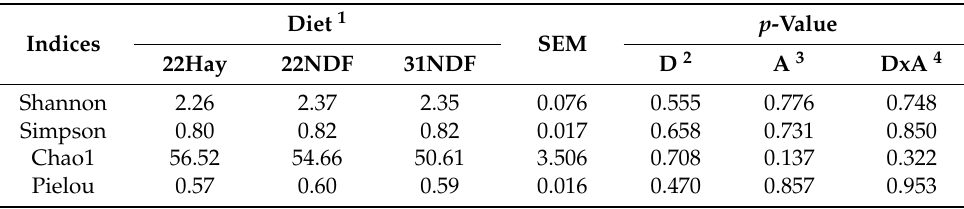
Table 2. α -diversity in ruminal fluid of dairy calves fed solid diets containing different levels and sources of NDF.